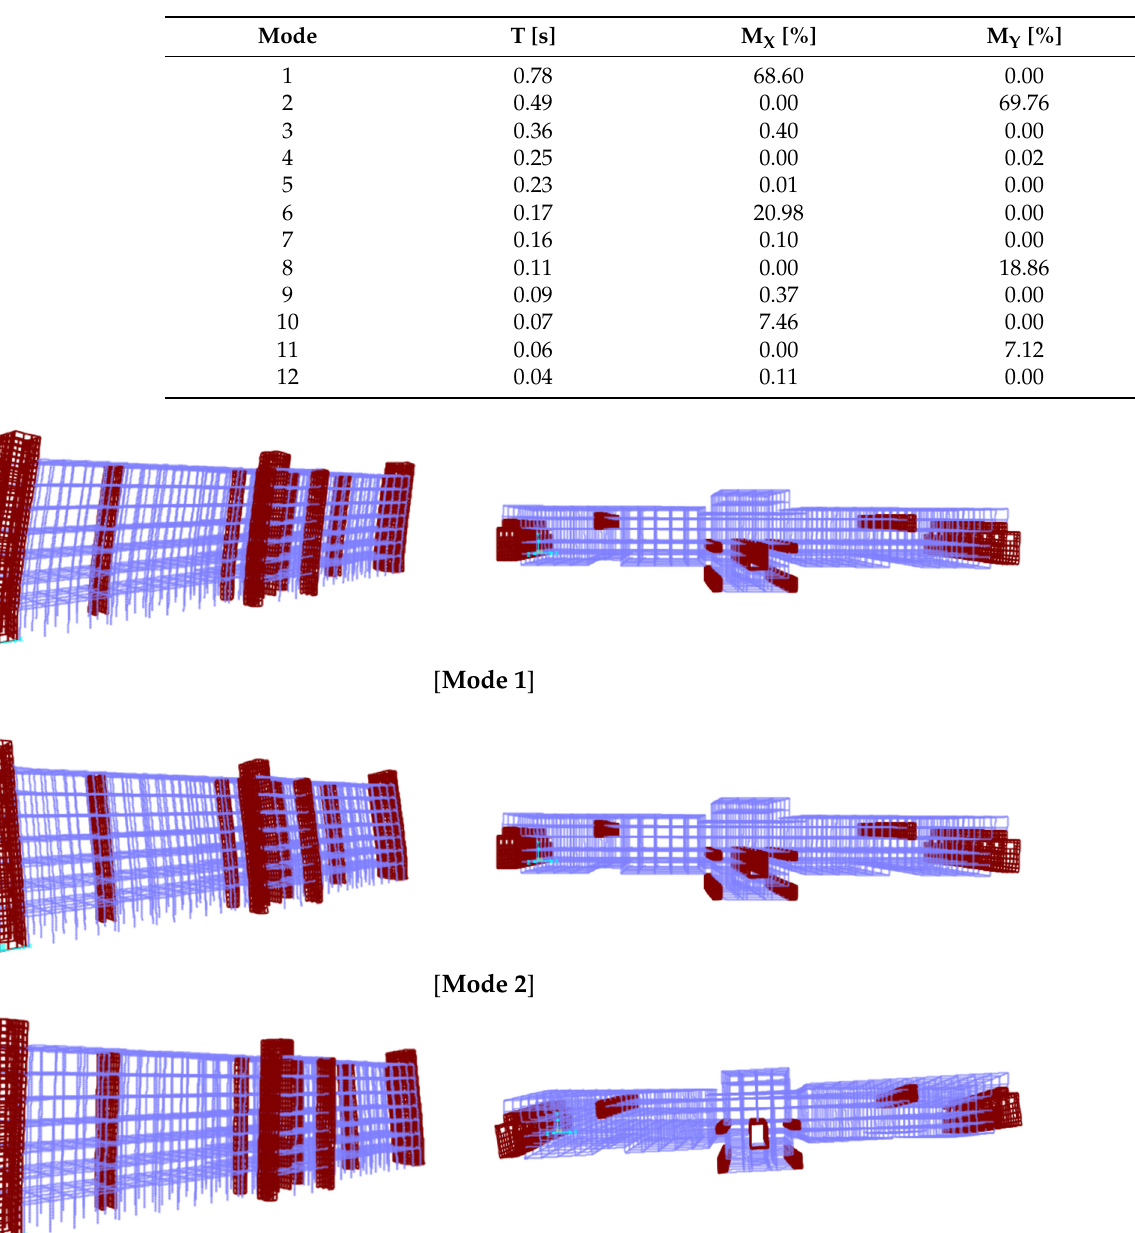
Figure 7. View of FE model developed in SAP2000 [21]. Table 7. Dynamic characteristics of the structure.